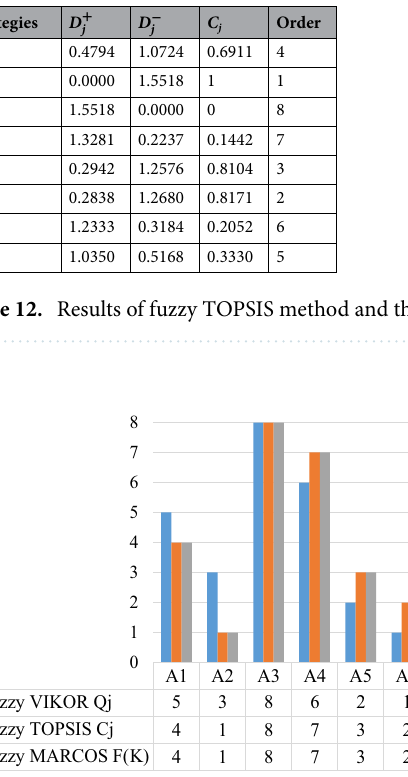
Figure 7. Compared ranked orders of the strategies.